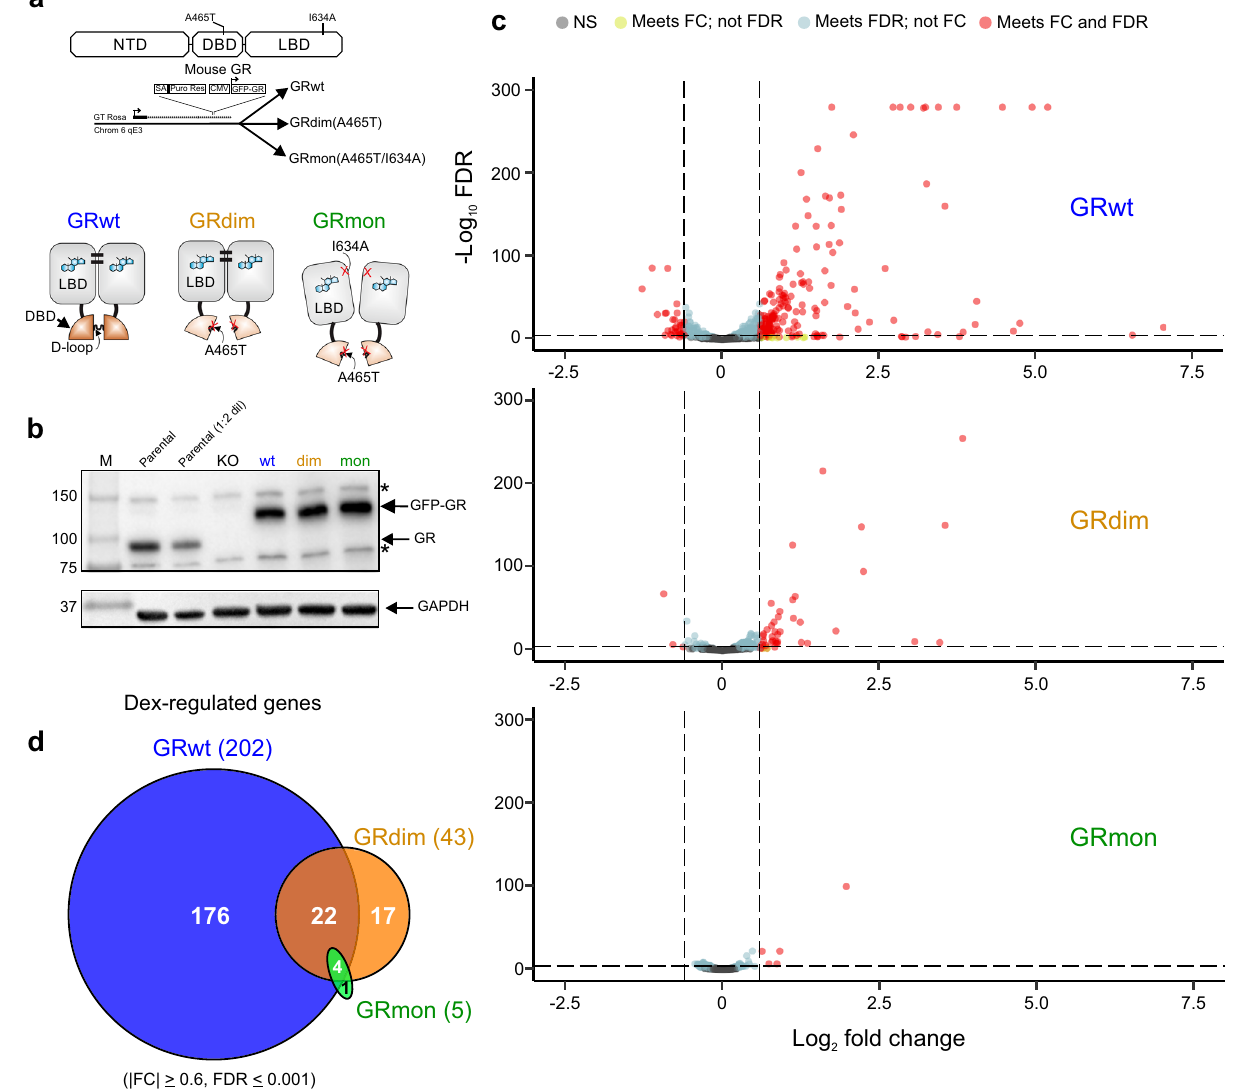
Fig. 1 GRdim and GRmon display attenuated transcriptional regulation compared to GRwt. a The parental and GRKO cell lines were derived from a C127 murine cell line (3617). The parental cell line contains endogenous GR while the GRKO has endogenous GR knocked out via CRISPR-Cas9. The Cartoon represents the GR mutants used in this study. The wild-type (GRwt) dimerizes through at least two surfaces, located in the ligand binding domain (LBD) and the Distal (D) loop within the DNA-binding domain (DBD). GRdim has a point mutation (A465T) which affects DBD-DBD contacts but remains dimeric through LBD-LBD interactions. GRmon has the A465T mutation as well as an LBD mutation and is therefore monomeric. The GRwt, GRdim, or GRmon of mouse GFP-GR were re-introduced separately into the GRKO cell line and constitutively expressed. b Western blots for GR. GAPDH is a loading control. M, molecular weight marker. Endogenous GR, GFP-GR and GAPDH bands are highlighted on the right with arrows; * denotes non-speci fi c bands. GAPDH blot was repeated on a separate gel due to an air bubble during protein transfer (Supplementary Fig. 9). The absence of a GR band in the KO cell line was independently con fi rmed three times, while the expression levels of GR mutants were done twice. c Volcano-plot representation from RNA-seq data after 2 h Dex treatment. NS, non-signi fi cant. FC, fold change. FDR, false discovery rate. The dashed lines indicate the thresholds used (|FC|> 0.6, FDR < 0.001) and the different colors in each datapoint indicate whether they meet FC, FDR, or both criteria. d Venn diagram of differentially expressed genes from RNA-seq data after 2 h Dex